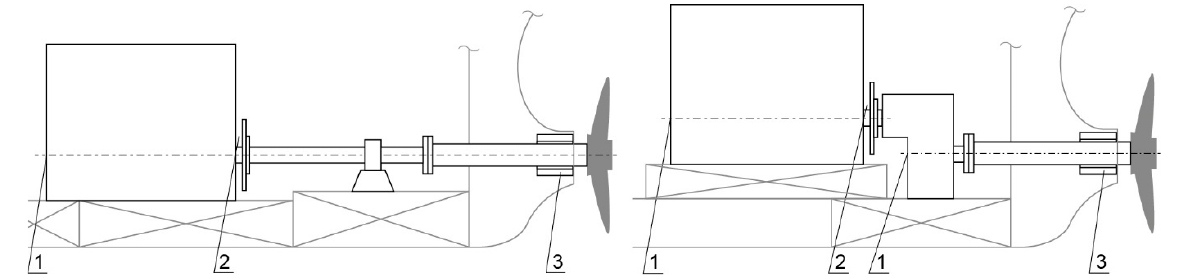
Figure 22. The arrangement of sensor heads for diagnosing diesel engine propulsion lines: 1—head of shaft free end sensors, 2—head of shaft position sensors, 3—head of stern bearing sensors.